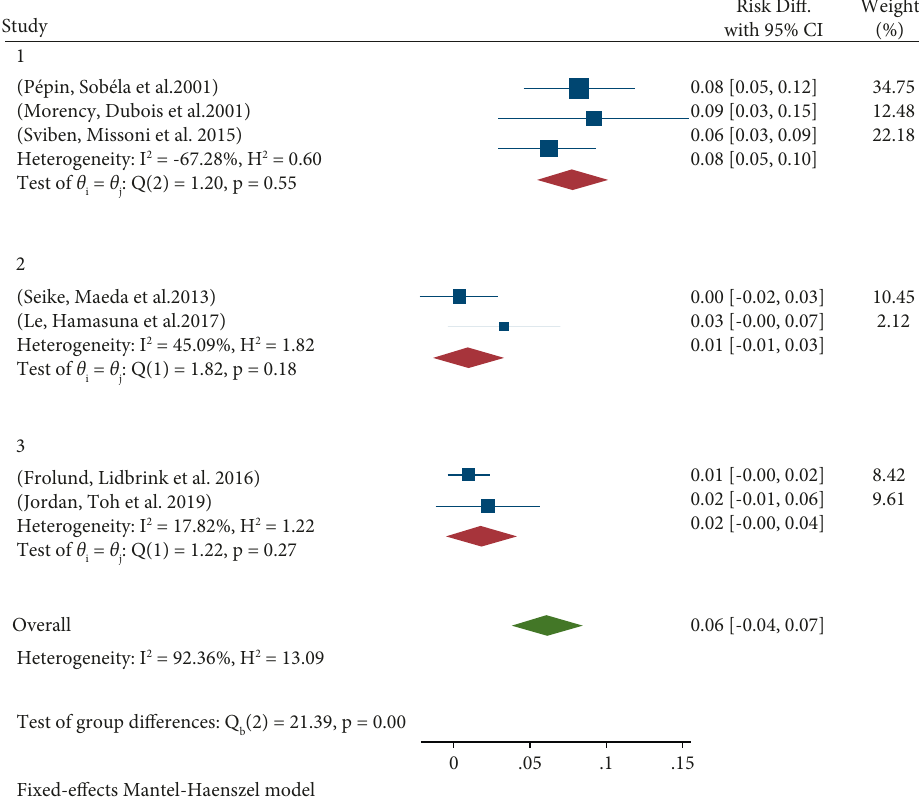
Figure 2: Forest plot of prevalence rate of T. vaginalis in male urethritis patients. L ′ Abbé plot